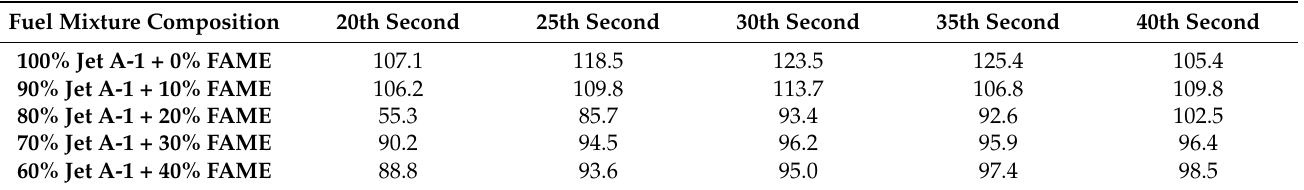
Figure 10. Graphical course of change in the total air temperature behind the compressor SJE-20 t 2t [°C] when using different mixtures of Jet A-1 aviation kerosene and FAME biofuel. Table 12. Change in total air temperature behind compressor t 2t [°C] SJE-20 with different concen- Table 12. Change in total air temperature behind compressor t 2t [ ◦ C] SJE-20 with different concentra- trations of Jet A-1 aviation kerosene and FAME biofuel. tions of Jet A-1 aviation kerosene and FAME